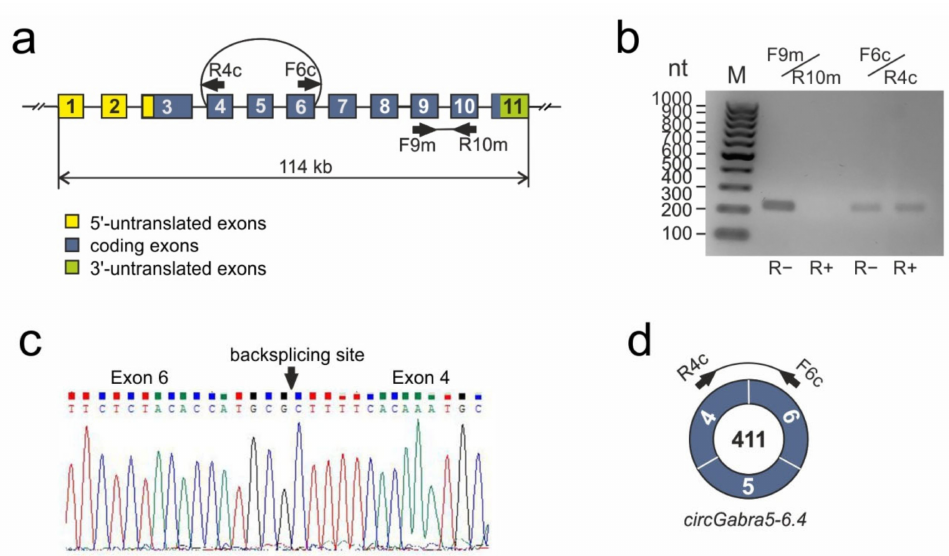
Figure 2. An analysis of circRNA diversity in tMCAO rat model conditions. ( a ) The exon-intron structure of the rat Gabra5 gene. Exons were shown as numerated blocs and the separating introns, as straight lines connecting rectangles. Arcs connect the ends of exons involved in the formation of circRNA. Primers (F, forward; R, reverse) are shown as arrows, the direction indicates the 5 (cid:48) - 3 (cid:48) -orientation. ( b ) Electrophoretic separation of the cDNA amplification products of the rat brain in the presence of primers complementary to exon sequences of the Gabra5 gene. On the left, the position of markers bands is indicated by GeneRuler 100 bp DNA Ladder (Thermo Fisher Scientific, Waltham, MA, USA). ( c ) Sanger sequencing result of circGabra5-6.4 matched to regions of exons that participated in back-splicing. It was visualized using Chromas Lite (Technelysium Pty Ltd, South Brisbane, Australia) software. ( d ) The structure of circRNA circGabra5-6.4 of the Gabra5 gene, whose formation was confirmed using PCR and Sanger sequencing. The number inside the circle is the length of circRNAs (nucleotides), figures in the circle segments are the numbers of exons inside the